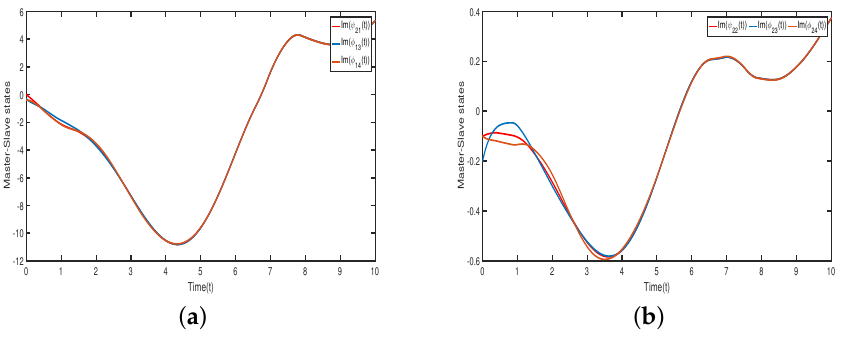
Figure 4. ( a ) The imaginary parts of state trajectories of CVNNs (23) and (24) for h = 2, i = 3. ( b ) The imaginary parts of state trajectories of CVNNs (23) and (24) for h = 2, i = 4.